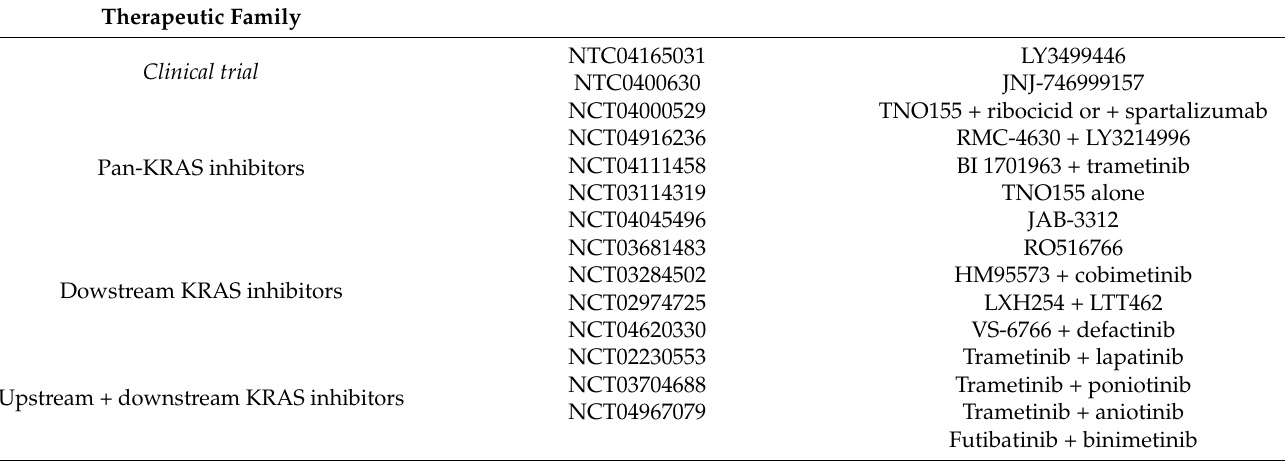
Table 1. A few examples of ongoing clinical trials based on inhibitors targeting KRAS in non-small cell lung